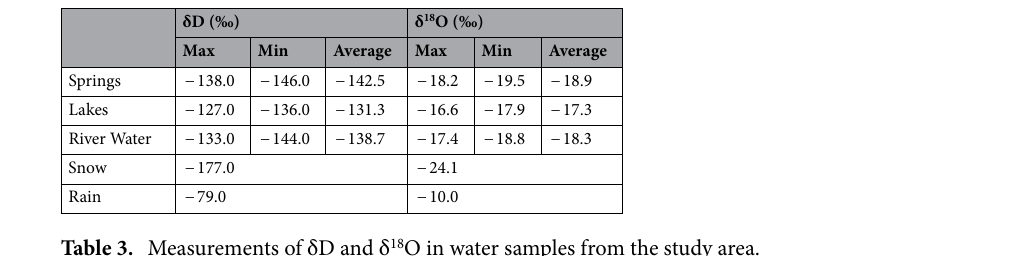
Table 3. Measurements of δD and δ 18 O in water samples from the study